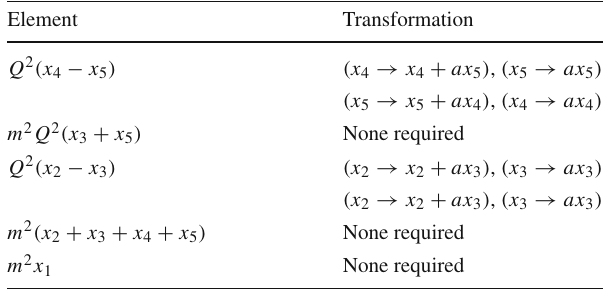
Table 2 Mapping Gröbner basis elements to coordinate origin, plane or curve via linear transformations Element